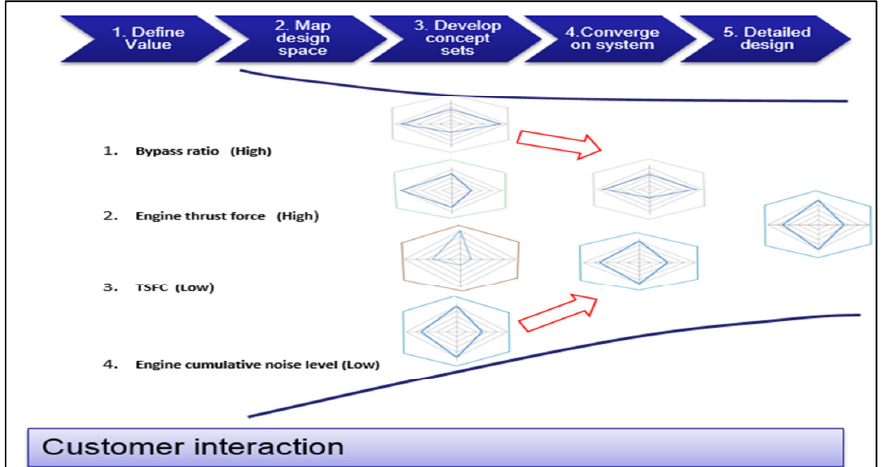
certain trade-off variables as identity in figure (10).